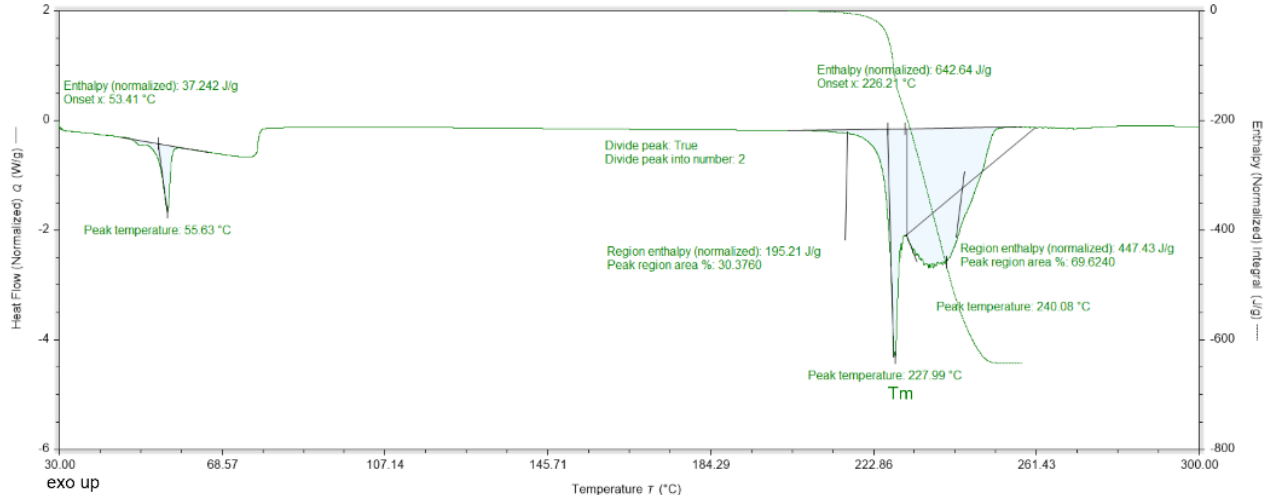
Figure 2. Graphical representation of the results from the DSC analyses for DMG-Am. The maximum of the endothermic peak, corresponding to the melting temperature (Tm) is denoted.